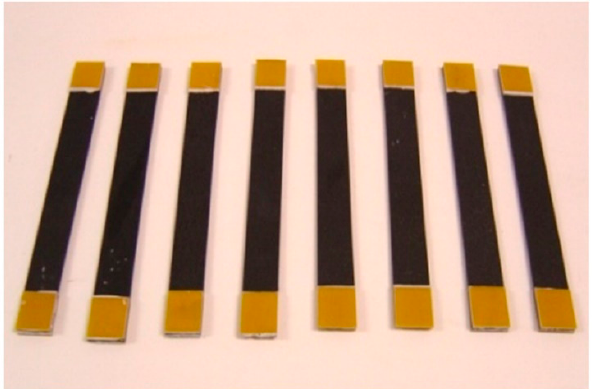
Figure 3. Rectangular specimens of the composite laminate with a [0/±45/90] S layup. (Specimen dimensions: 135 mm × 15 mm × 1.35 mm).